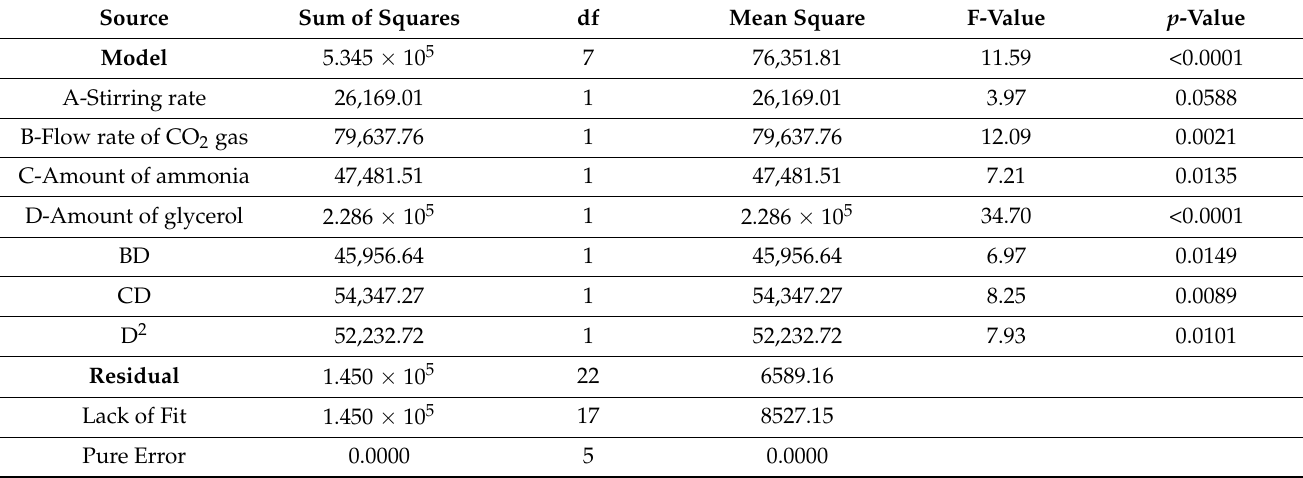
Table 8. ANOVA analysis table for response 1: particle size of CaCO 3 .